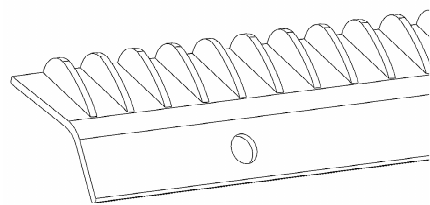
Figure 3. Schematic diagram of the structure of the rasp bar.